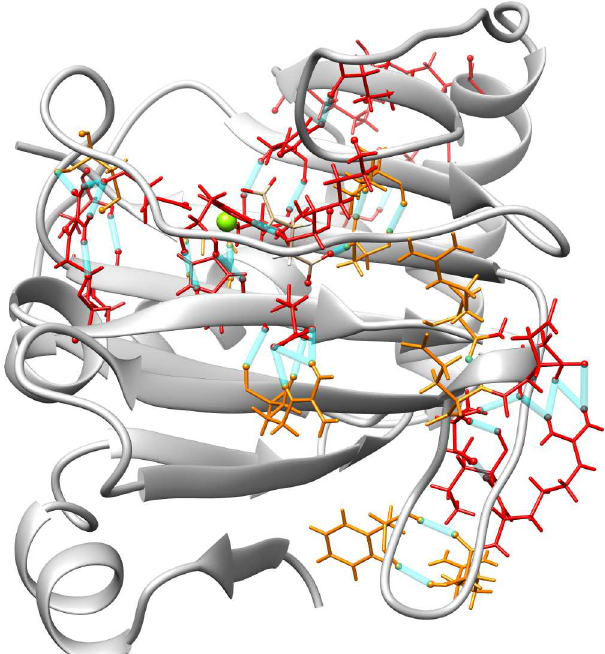
Fig 2. Hydrogen bond analysis for the WT/R191Q variant with α -kg. Residuescolored in red denote amino acids involvedin H-bondsfor over 30% of the WT trajectory and brokenfor over 90% of the R191Q variant trajectory. Residuescolored in orangeare involvedin hydrogenbondsfor both trajectories,but are present for at least 30% less of the time in the variant trajectory. The hydrogenbondsbetweenthese residues are displayedin blue. The corresponding analysisfor the WT/SNP variant with succinate are given in the Supplementary Information.